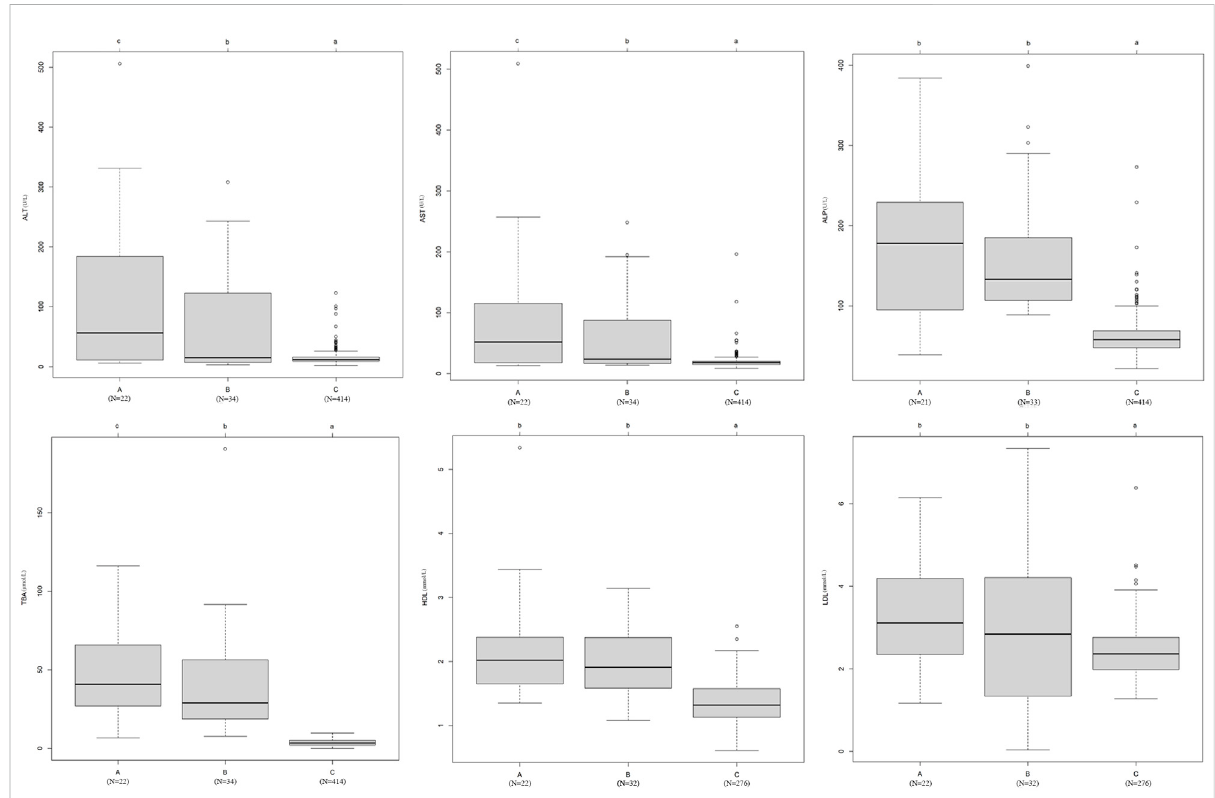
FIGURE 5 Effects of bile acid transporter and receptor gene mutations on biochemical indices. The difference in the average levels of ALT, AST, ALP, TBA, HDL,andLDLinthefollowinggroups: (A) 24novelmutationsinthedamaginggroup, (B) 38novelmutationsintheprobablydamaginggroup,and (C) healthy control individuals without ICP disease. The means of different groups in rows with different superscript letters are signi fi cantly ( p < 0.05) different from each